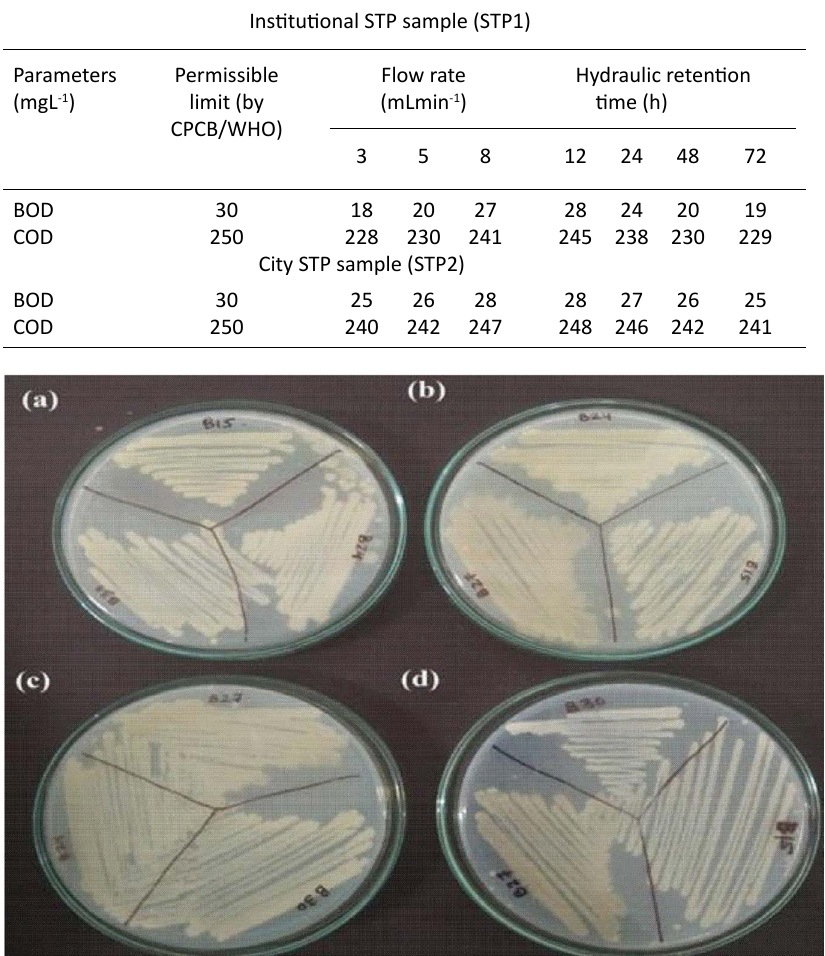
Table 5. Effect of flow rate and hydraulic retention time in the bioreactor for